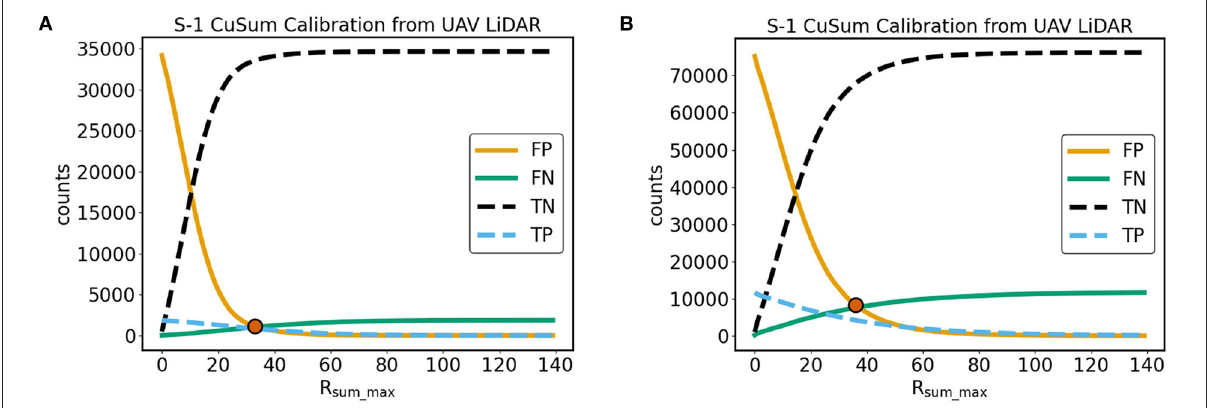
FIGURE4 Calculating the value of the CuSum maximum ( R sum _ max ) from Sentinel-1 (S-1) time series that would minimize both False Positive (FP) and False Negative (FN) change detections in (A) Gabon and (B) Peru. The optimum value is indicated by a circle at the point of intersection between the FP and FN curves. Change is defined as a canopy height loss ≥ 10 m as derived from a UAV LiDAR 1 CHM raster resampled to 10 × 10 m pixels. The counts in Peru are double the size than Gabon as here the S-1 time series spans 2 years, consistently with the timeframe of the UAV LiDAR acquisitions. True Positive (TP) and True Negative (TN) curves are also shown in this